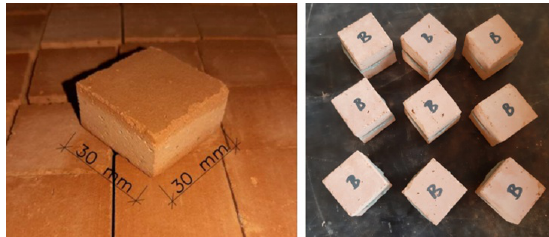
Figure 1. The fired clay in the form of plates and the produced samples.